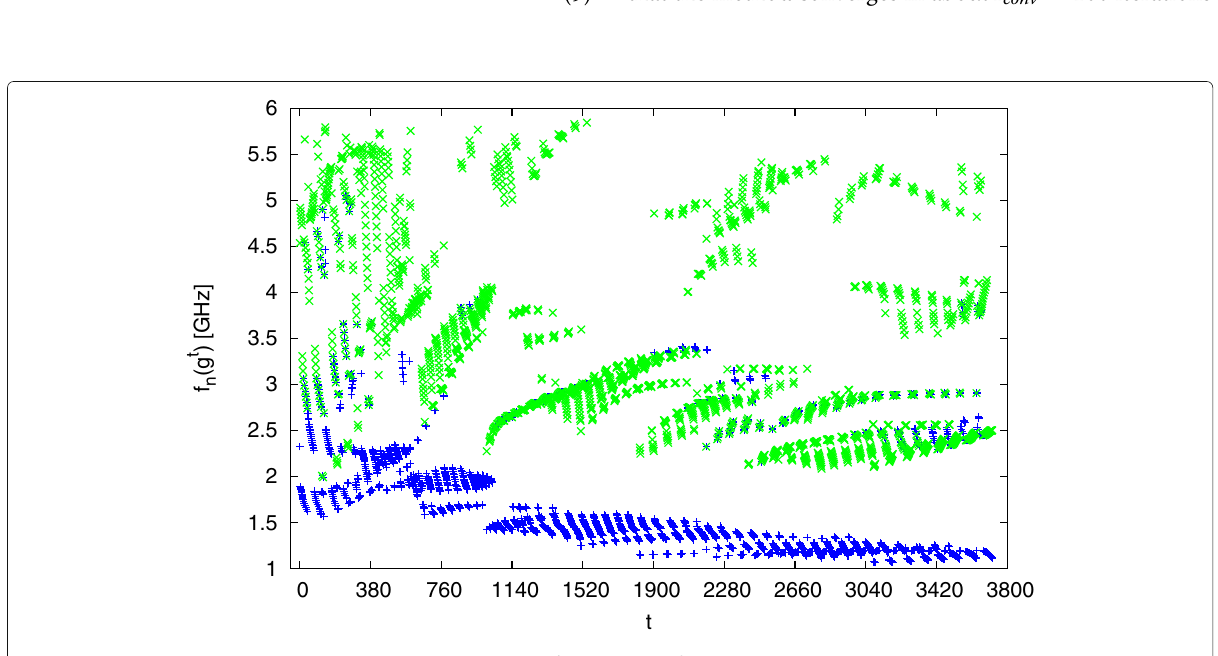
(cid:4) (cid:5) (cid:13) g ( t ) , n = 1,.., N , t = 1,..., T of the T = 3721 OA-defined training samples ( n = 1 → blue cross; n = 2 → f n